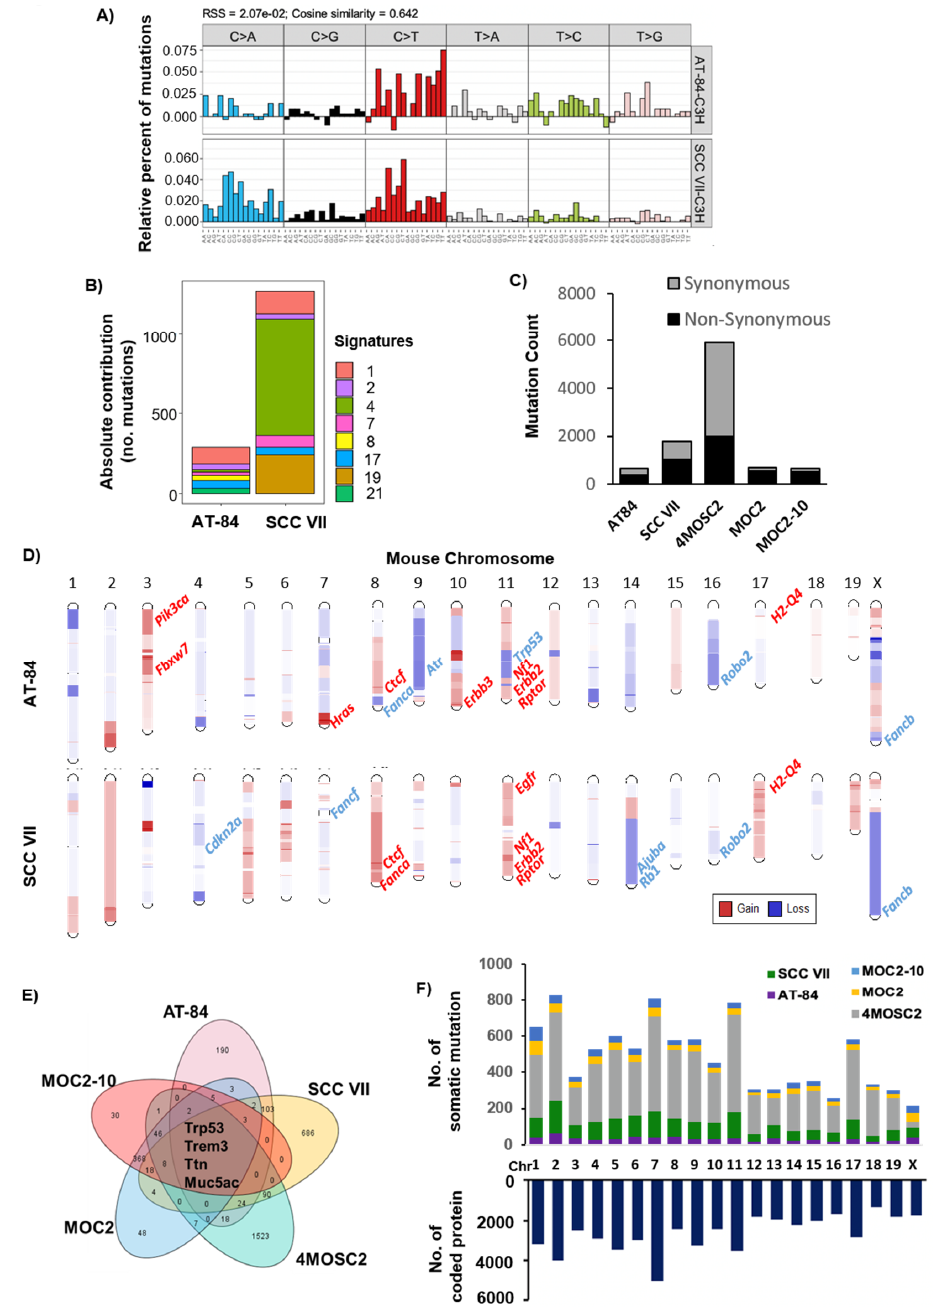
Figure 1. Comprehensive characterization of mouse head and neck cancer (HNC) models. ( A ) Mutational spectrum of all base substitutions of AT-84 and SCC VII. Di ff erent substitutional types are indicated in the vertical axes. ( B ) Mutation signatures of AT-84 and SCC VII. Bar plot showing the contribution of Catalogue of Somatic Mutations in Cancer (COSMIC) mutational signatures to reconstructing 96 mutational profiles. Color-coded columns represent di ff erent COSMIC signatures according to the legend on the right. ( C ) Bar plots showing mutation rates of AT-84, SCC VII, MOC2, MOC2-10, and 4MOSC2, respectively. The total number of synonymous and non-synonymous mutations are shown in grey and black bars, respectively. ( D ) Chromosomal gains (red) and losses (blue) in AT-84 and SCC VII. Some key HNC tumor-related genes are labeled. ( E ) Venn diagram showing overlapping somatic non-synonymous mutations among 5 mouse models, with numbers indicating somatic non-synonymous mutation number in each model. ( F ) Distribution of mutational events across mouse chromosomes with di ff erent colors representing events from di ff erent models (upper panel). The numbers of coding proteins in each mouse chromosome are shown (lower